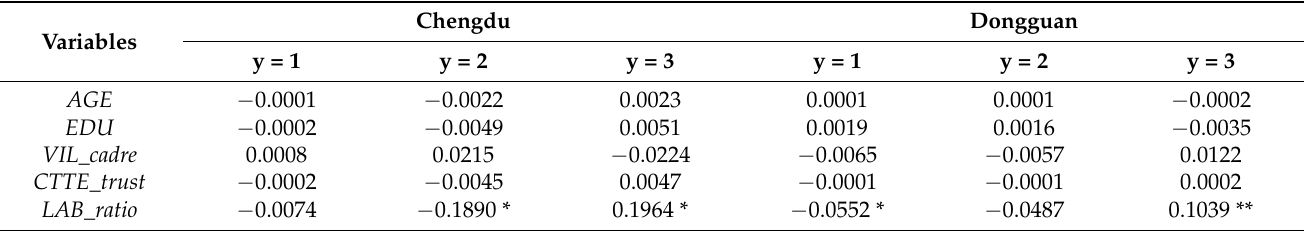
Table 11. Analysis of marginal